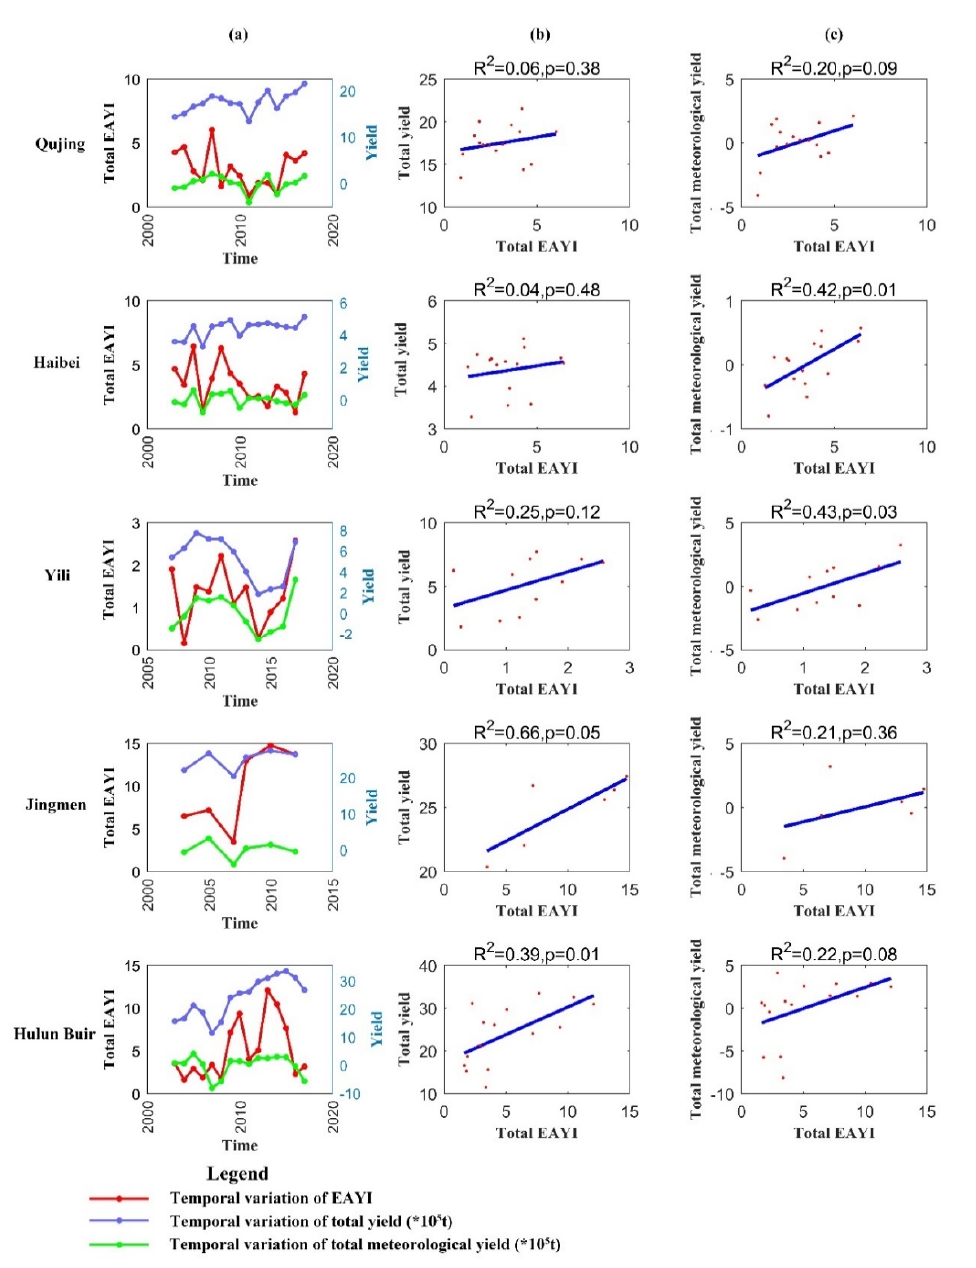
Figure 9. ( a )The temporal variation of total EAYI, total yield and total meteorological yield in five subareas; ( b ) The relationship between total EAYI and total yield in five subareas; ( c ) The relationship of total EAYI and meteorological yield in five subareas.